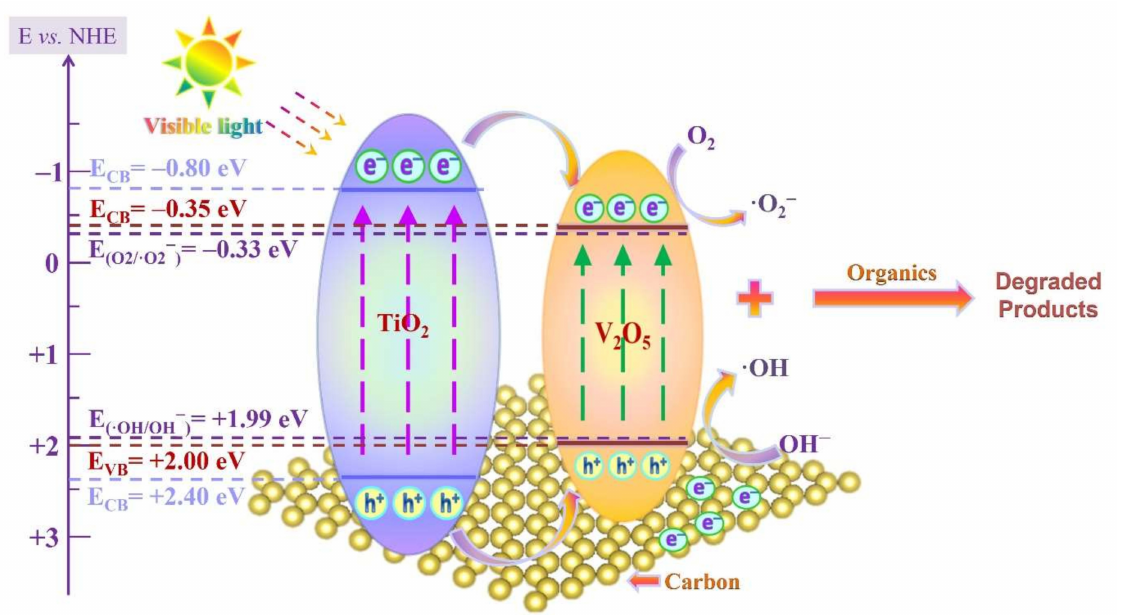
Figure 6. Schematic diagram of photocatalytic degradation of MB by VOGTO2 under visible light irradiation.